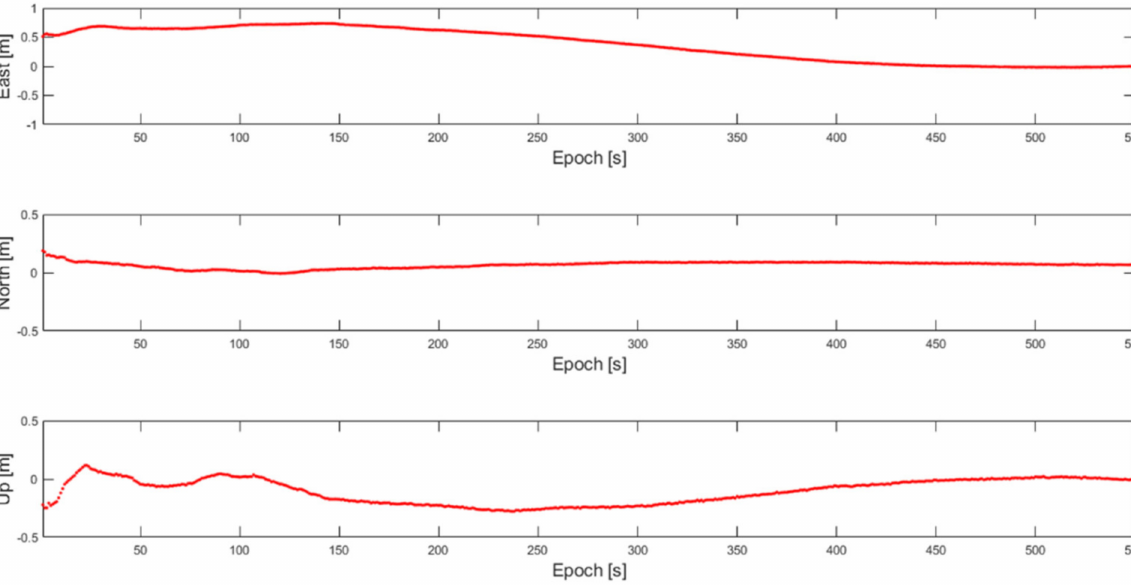
Figure 14. Positioning errors of the broadcast baseline due to injected one cycle offset in one of DD integer